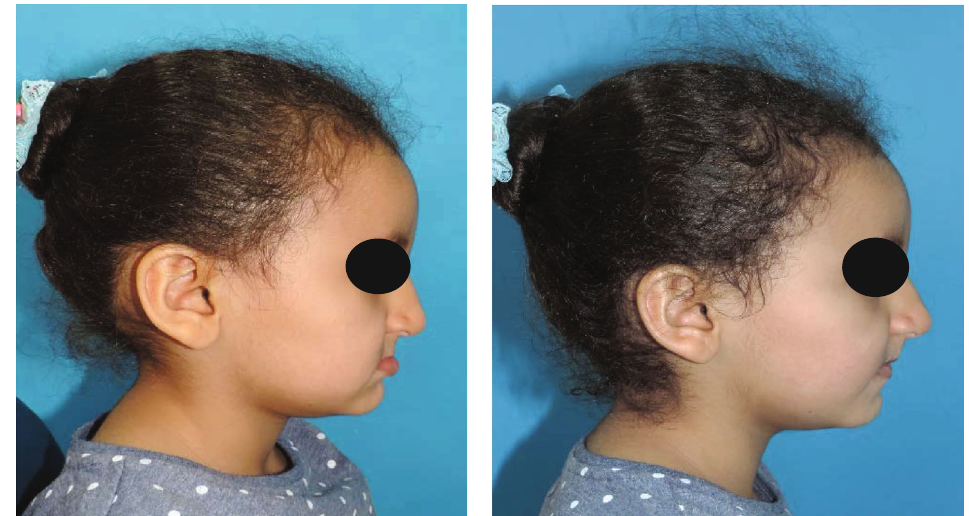
Figure 4: Pretreatment and postplacement of the appliance showing de fi nite improvement in the patient ’ s pro fi